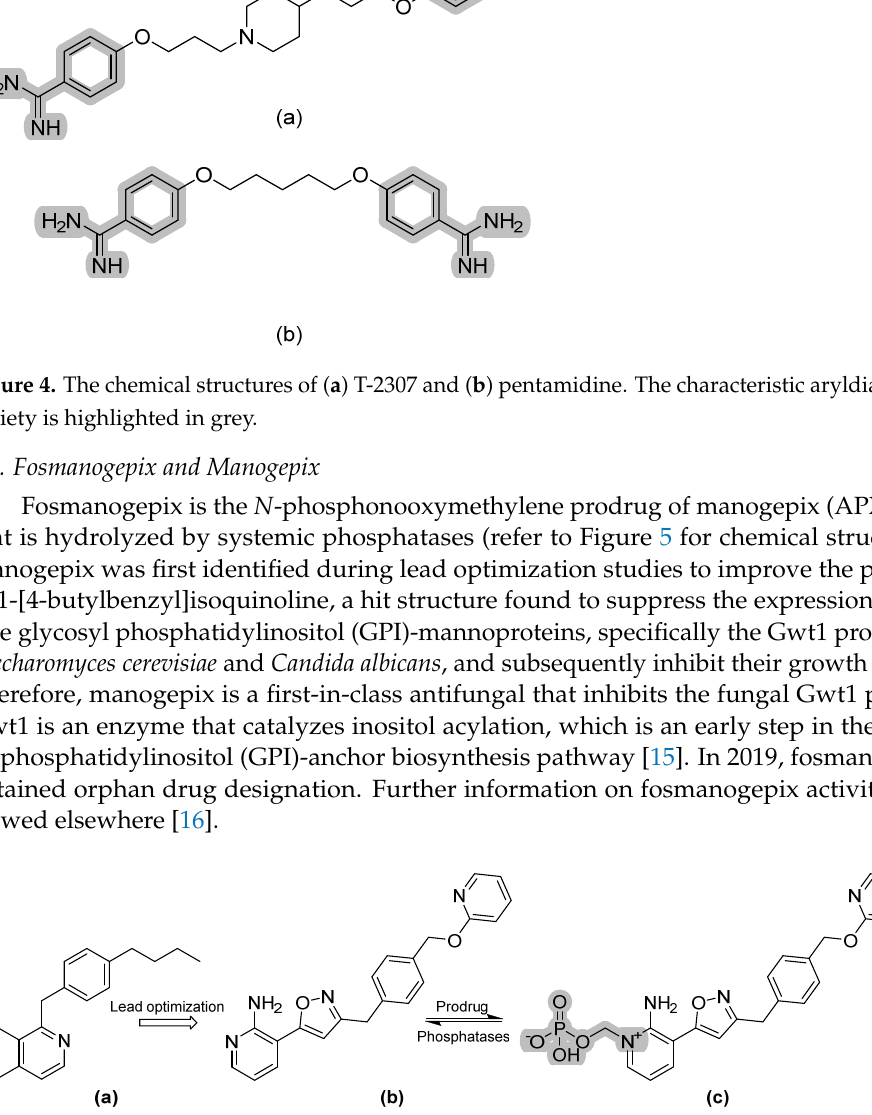
Figure 5. The chemical structures of ( a ) 1-[4-butylbenzyl]isoquinoline, ( b ) manogepix, and ( c ) fosmanogepix.